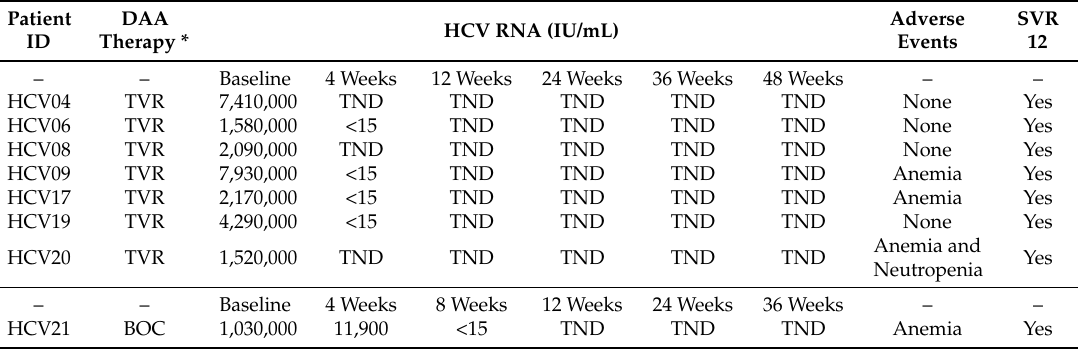
Table 2. Direct-acting antiviral (DAA) therapy, HCV RNA viral load, adverse events, and treatment response.